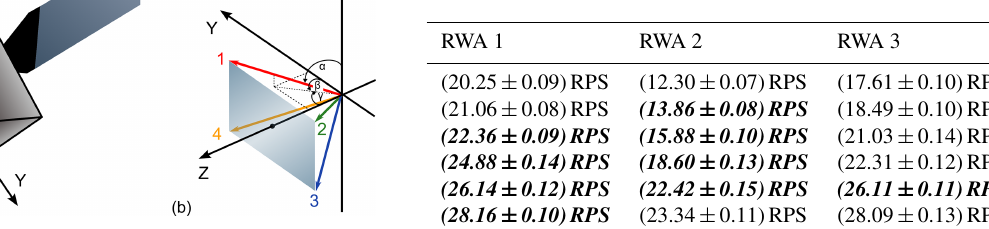
Table 3. Same as Table 2 but for the analyzed period between 14 and 21 October 2019 (FM-B